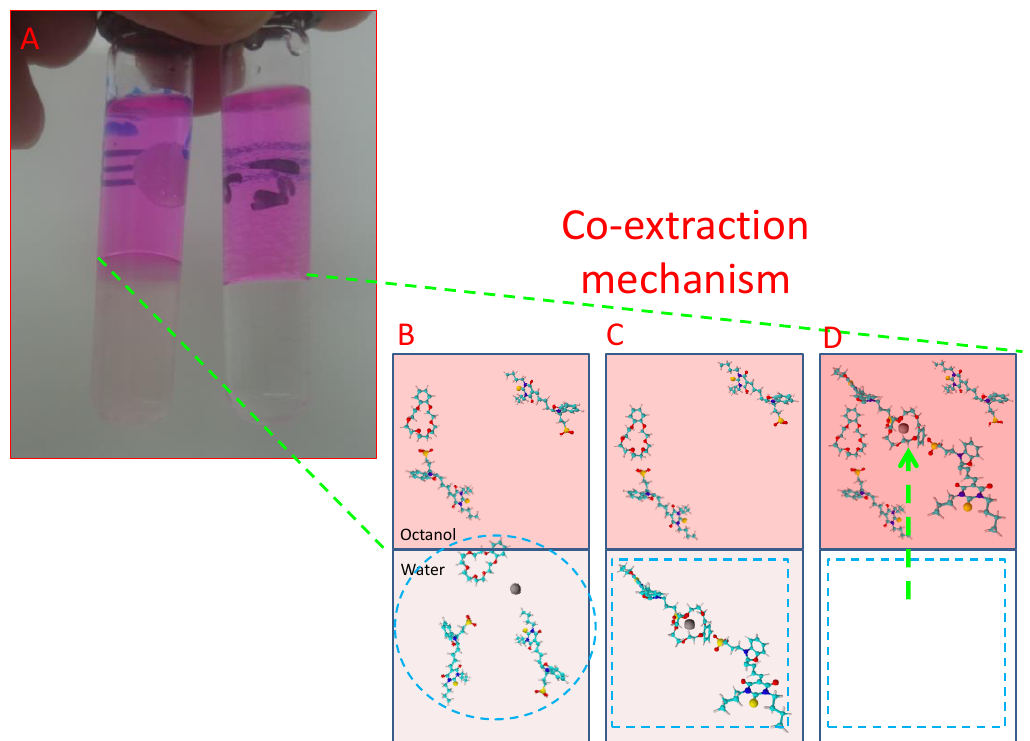
Figure 1. ( A ) test tubes with separated octanol/water sensor cocktails: zero level (left) and 500 ppm Pb 2+ . ( B ) Cartoon showing the co-extraction three step principle by ( B ) Pb 2+ introduction near one